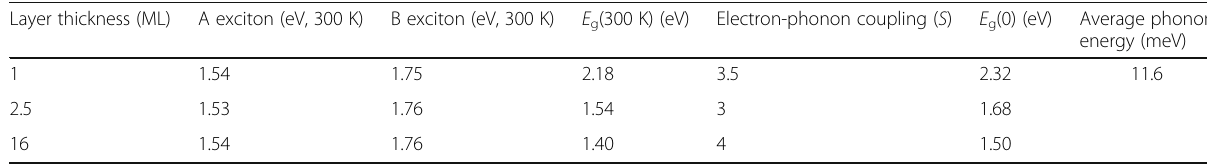
Table 1 Exciton peak energies and the fitting parameters from Eq. (1) for the 1, 2.5, and 16 ML of MoSe 2 films Layer thickness